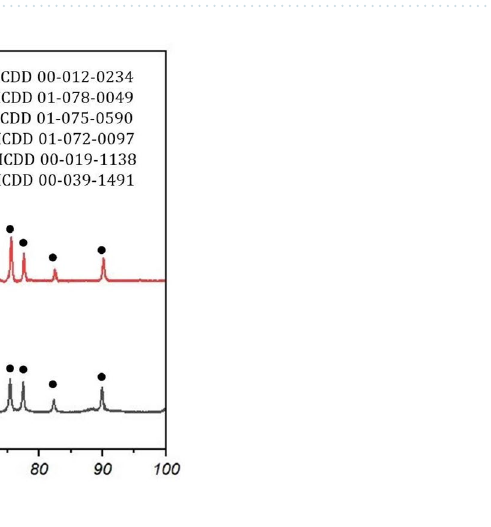
Figure 1. FESEM micrographs of mixed powders after 8 h milling process ( a ) low magnification and ( b ) high magnification.